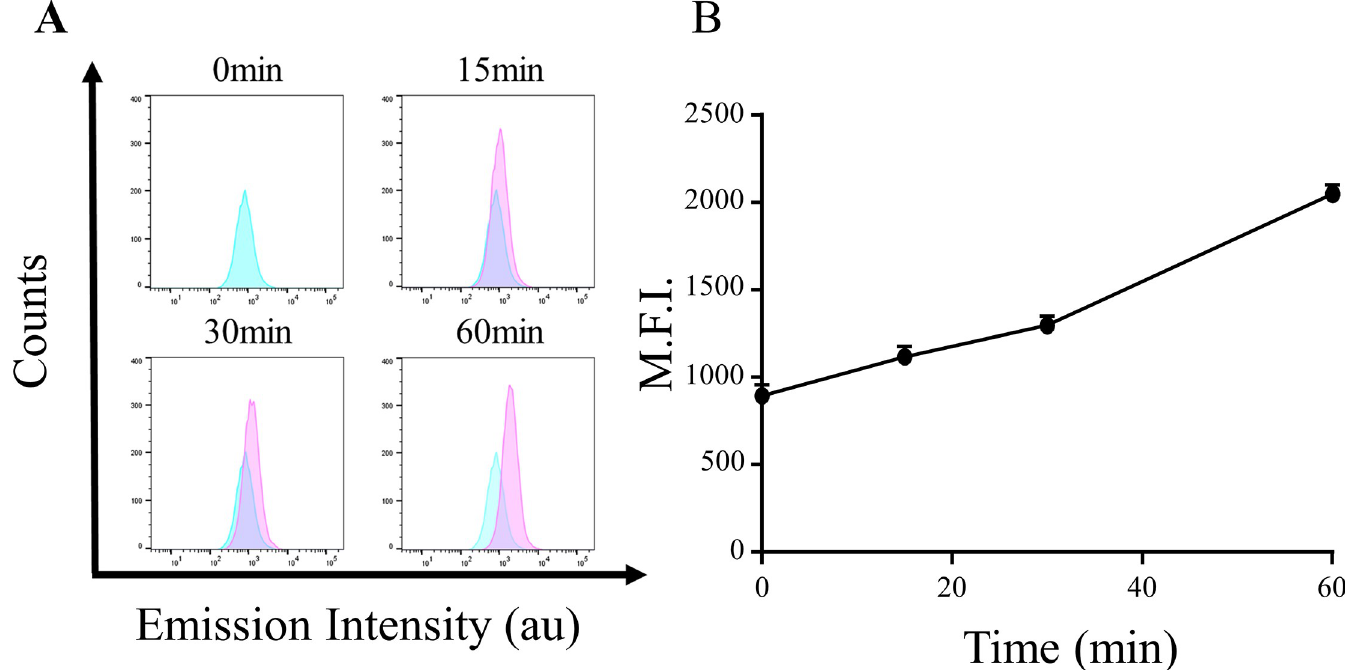
Fig 2. PpIX accumulation in GIST-T1 cells in vitro . GIST-T1 cells were loaded with PpIX for different durations. Accumulation of PpIX within cells was analyzed using FACS with excitation at 405 nm and emission at 680 nm. (A) Histogram data from FACS. The abscissa (X-axis) indicates intensity of emission and the ordinate (Y-axis) represents number of cells. The green and red histograms represent cell samples at 0 min (as a control) and cell samples at each indicated time point, respectively. (B) Temporal changes in mean fluorescence intensity (M.F.I.). The abscissa (X-axis) indicates time and the ordinate (Y-axis) of the graph represents M.F.I.